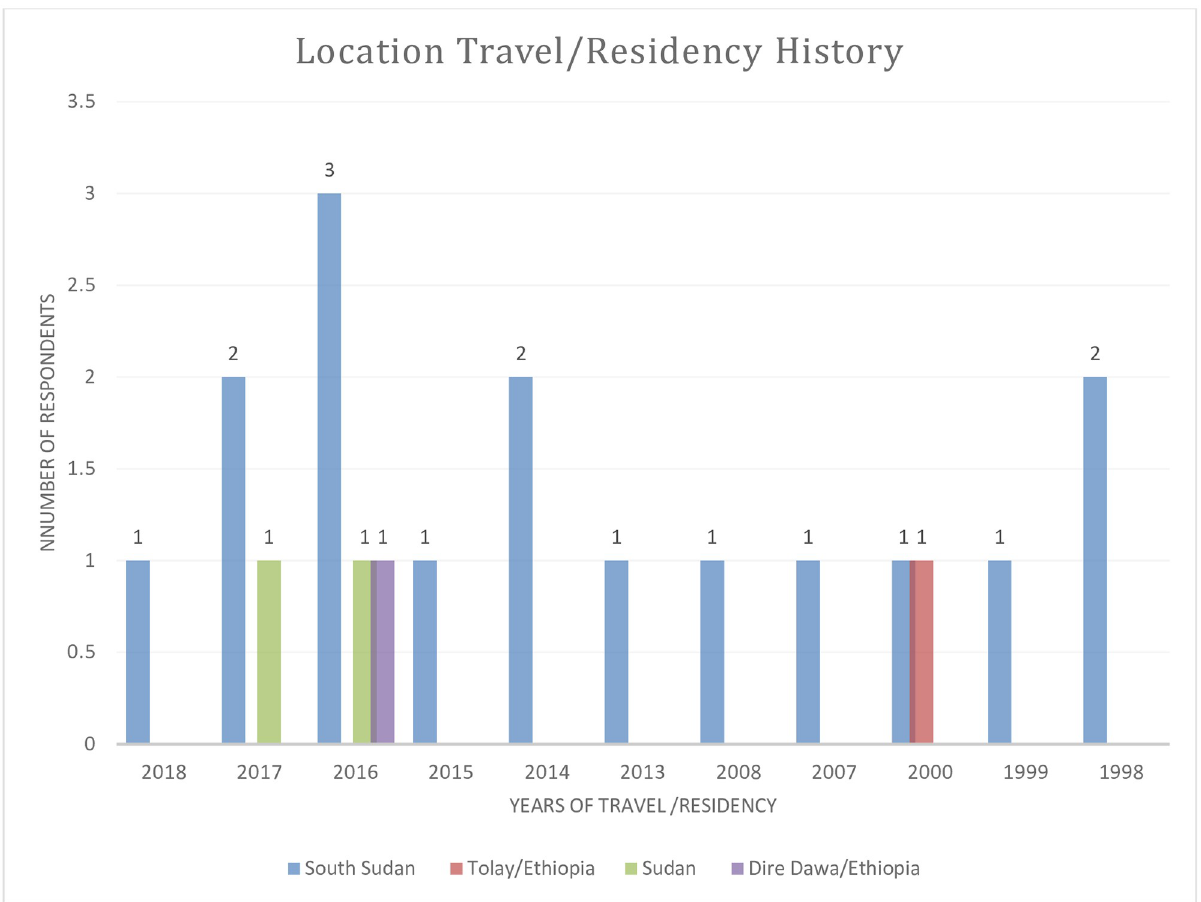
Fig 2. Traveling and residence out of Gambella region among those with a history of the